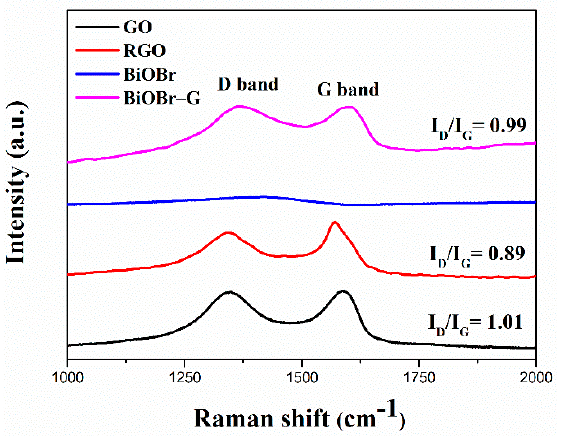
Figure 3. Raman spectra of the GO, RGO, BiOBr, and BiOBr-G nanocomposites. I D / I G is the ratio of the integrated intensities of the D and G